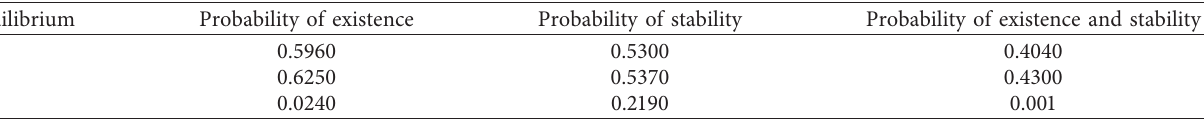
Figure 7: Probability distribution functions of the six sampled input parameters’ values. These results have been obtained from Latin hypercube sampling using a sample size of 1000. (a) β 1 . (b) β 2 . (c) α 1 . (d) α 2 . (e) c 1 . (f) c 2 . Table 5: Summary of probabilities of existence and stability conditions of equilibria.